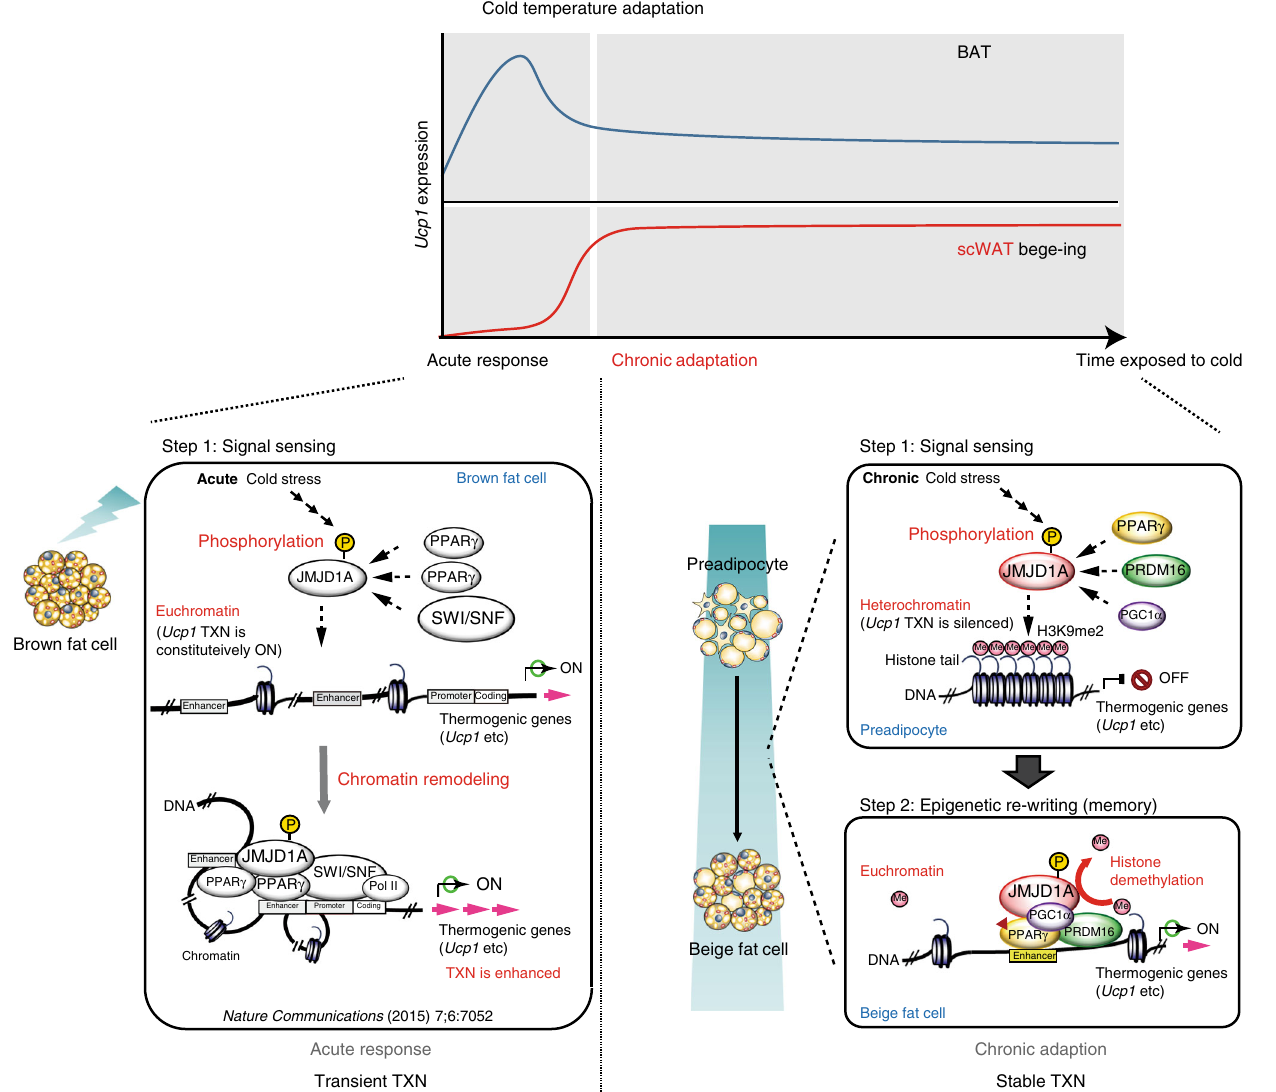
Fig. 8 Complementary mechanisms for thermogenic gene induction in acute and chronic cold stress via overlapping, but distinct mechanisms of JMJD1A. Brown fat cells mediate acute and robust thermogenic activation of Ucp1 , while scWAT-derived beige fat cells contribute to an adaptive response against chronic cold exposure (top). The acute response in BAT requires a BAR-dependent phosphorylation of JMJD1A that facilitates long-range enhancer- promoter interactions and stimulate thermogenic gene expressions, but this does not require the intrinsic H3K9me2 demethylation activity of JMJD1A (left bottom). The chronic adaptation in beigeing requires both phosphorylation-dependent chromatin recruitment and H3K9me2 demethylation activity of JMJD1A (right bottom). These histone demethylation-independent acute Ucp1 induction in BAT and demethylation-dependent chronic Ucp1 expression in beige scWAT ensure an ordered transition between acute and chronic adaptation to cold stress. TXN sonicated to be 0.5kb average in size was used for ChIP. Chromatin formaldehyde for 10 min were homogenized by passing through a 22 G needle 10 immunoprecipitated samples were used for library preparation with KAPA Hyper times in ice-cold hypotonic buffer B. Relative ChIP enrichment in Fig. 5j represents Prep Kit (Nippon Genetics), according to the manufacturer ’ s instructions 13,36 . the ratios of percentage input in the cells differentiated for indicated time, compared with in undifferentiated cells, which are de fi ned as 1. Deep sequencing was performed on a HiSeq 2500 sequencer (Illumina) as single- JMJD1A ChIP for scWATs was performed as follows. Fresh scWATs were minced, cross-linked with 1.5mM ethylene glycol bis(succinimidylsuccinate) (Thermo Scienti fi c) for 30 min at room temperature (RT), and then directly a (Illumina), based on the 36bp sequences. Signals of ChIP-seq occupancy are second crosslinking was performed by the addition of 1% formaldehyde for 10 min. presented as reads per million mapped reads (RPM). Nuclear pellets were resuspended in 2 ml cell lysis buffer C containing 0.2% SDS, and chromatin DNA was sheared to 2kb average in size through sonication. For ChIP, 5 μ g nuclear DNA containing nuclear lysates harvested from 140 to 200 mg Quantitative real-time PCR . qPCR was carried out in 384-well plates using the scWAT per head were immunoprecipitated overnight at 4°C with a mixture of two ABI PRISM 7900HT sequence detection system (Applied Biosystems). All reactions anti-JMJD1A antibodies (20 μ g each of IgG-F0618 and IgG-F0231) pre-bound to were done in triplicate. All primer sequences used in this article are listed and 200 μ l of Dynabeads protein G. shown in the Supplementary Tables 3 and 4. Copy numbers of Ucp1 mRNA in For JMJD1A ChIP in cultured cells, we used 30 μ g nuclear DNA containing BAT and scWAT were determined by qPCR, as described 37 , using a plasmid cross-linked nuclear lysates. For ChIP-seq analysis using JMJD1A antibody, containing mouse Ucp1 open reading frame as the standard template for Ucp1 . The precipitated DNA from original DNA size of ~2 kb was further sheared to ~200bp data were converted to copy number per ng of the total RNA. by an Acoustic Solubilizer (Covaris). For ChIP-seq using PPAR γ antibody, DNA